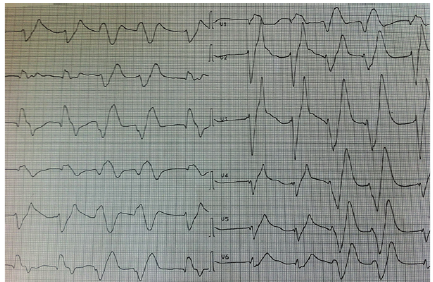
Figure 1: The electrocardiogram showing tall and peaked T waves, flattened and broadened P waves, and widened QRS complexes.